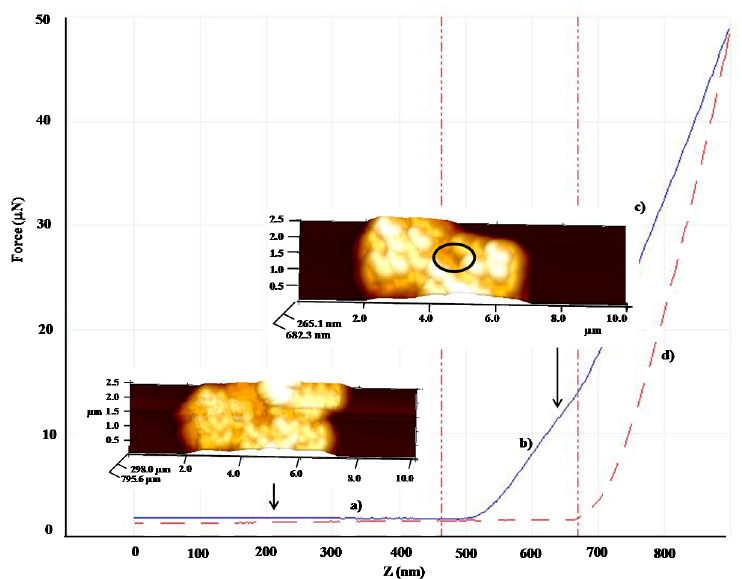
Figure 4. Mechanical testing of the elastic-plastic region by AFM of the MPCM composed by PMMA:tetracosane (1:3) microcapsule at 60 °C: ( a ) no contact, blue continuous line; ( b ) plastic penetration; ( c ) deformation of the sample; and ( d ) retraction of the AFM probe, red discontinuous line.